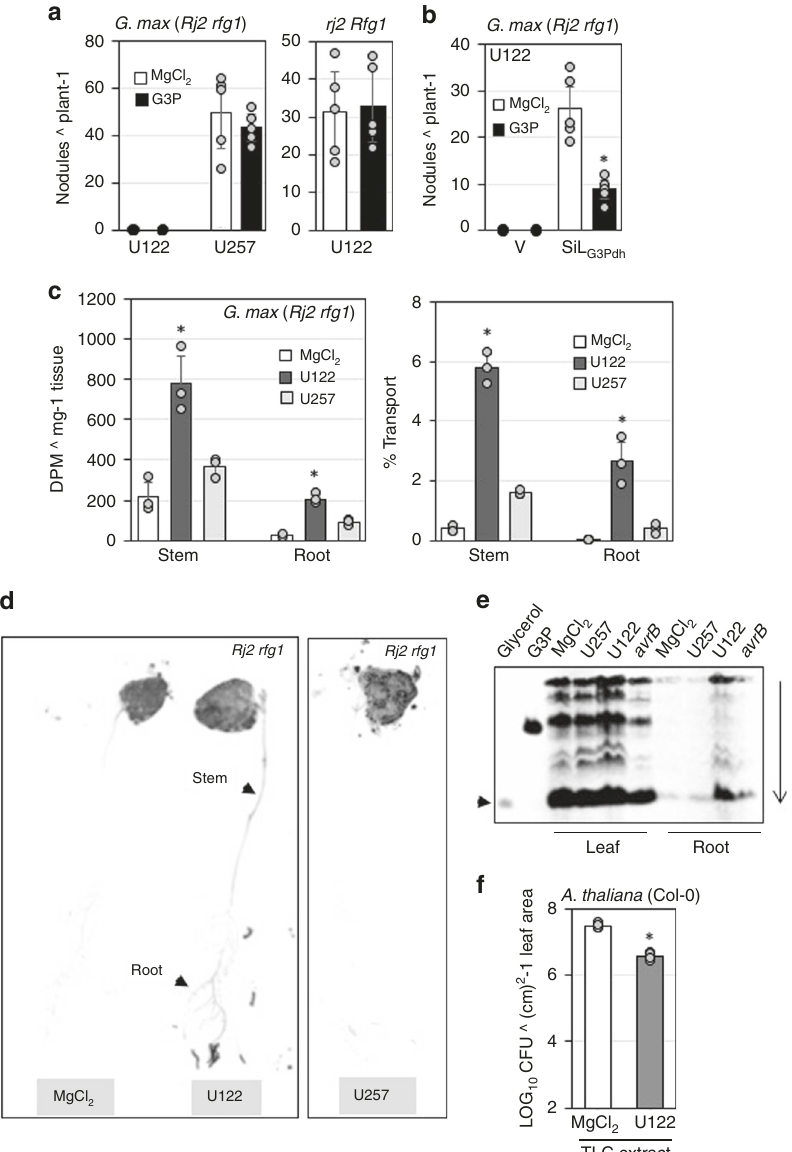
Fig. 7 Incompatible rhizobia induce shoot to root transport of G3P. a , b Average number of nodules produced by U122 or U257 on a wild-type, b control VIGS vector inoculated (V) or G3Pdh knockdown (Sil G3Pdh ) Rj2 rfg1 plants, that were leaf-in fi ltrated with MgCl 2 or G3P 24 h after rhizobia inoculation. Black circles on x axis indicates absence of nodules. c Quanti fi cation of radioactivity (left panel) and percentage 14 C-G3P transported (right panel) to stem and roots of Rj2 rfg1 plants that were root-inoculated with buffer (MgCl 2 ), U122 (incompatible), or U257 (compatible) followed by leaf in fi ltration with 14 C-G3P. 14 C levels were measured 48 h later. d Autoradiograph of Rj2 rfg1 seedlings that were root-inoculated with MgCl 14 C-G3P 2 , U122 or U257 followed by in fi ltration in leaves. Images were obtained 24 h post 14 C-G3P in fi ltration. e Autoradiograph of thin-layer chromatogram (TLC) of leaf and root extracts prepared from plants that were root-inoculated with MgCl 2 , U122 or U257 followed by leaf in fi ltration with 14 C-G3P. 14 C-G3P and 14 C-glycerol were loaded as controls. The extracts were prepared 48 h post rhizobia inoculation and chromatographed on a cellulose plate. Vertical arrow indicates direction of run. Arrowhead indicates glycerol. f Pst Vir counts in leaves of Arabidopsis thaliana (Col-0) plants that were pre-in fi ltrated with TLC separated root extracts from MgCl 2 or U122-inoculated Rj2 rfg1 soybean plants as in ( e ). Root extracts from Rj2 rfg1 plants inoculated with MgCl 2 or U122 (root) were separated on TLC. TLC extracts were in fi ltrated into A. thaliana plants followed by Pst Vir inoculation on systemic leaves, 48 h later. LOG 10 values of colony forming units (CFU) ^ cm 2 -1 leaf area are presented. Error bars indicate standard deviation ( n = 4). Asterisks denote data signi fi cantly different from corresponding mock, Student ’ s t -test, P < 0.005. Results are representative of two-four independent